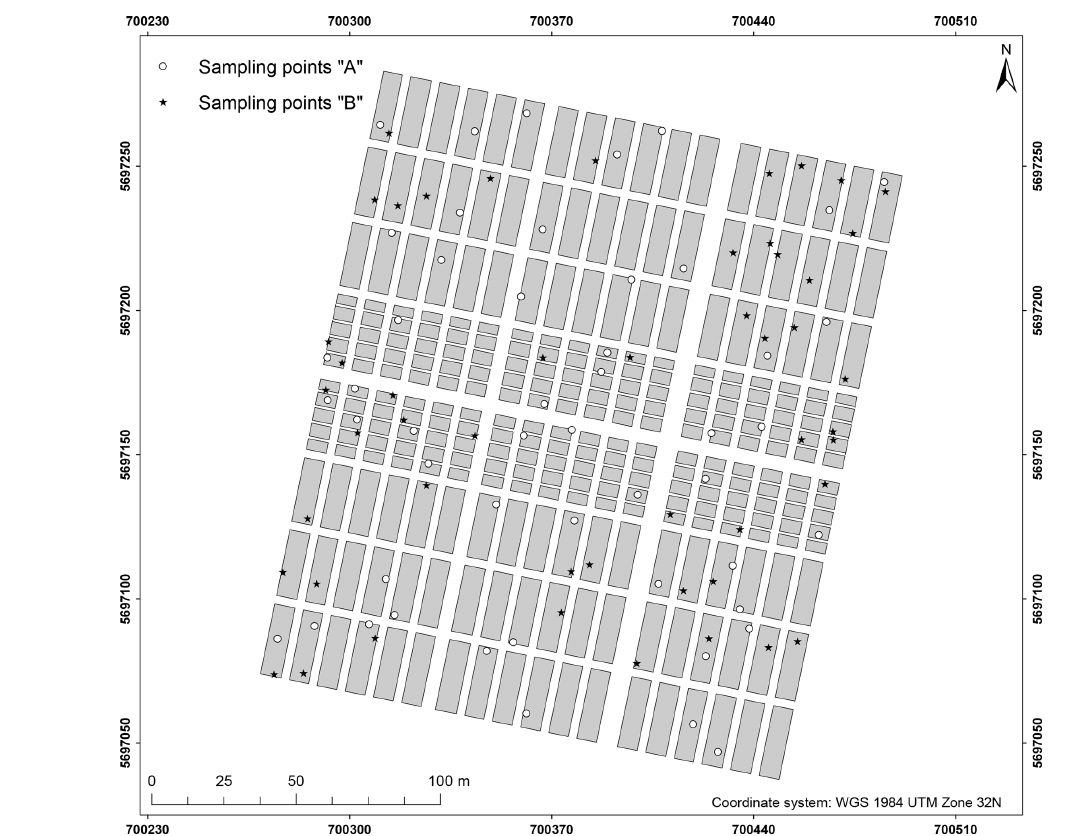
Figure 2. Site of the Static Fertilization Experiment in Bad Lauchstädt with LTFE plots and sampling points according to design A and B. Plot margins excluded from sampling are visible as 3m wide stripes between